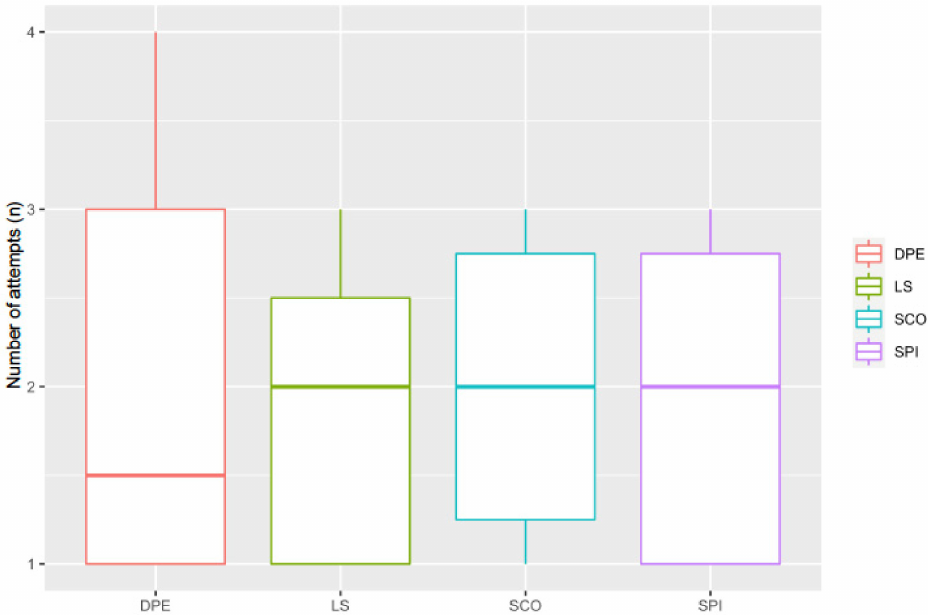
Figure 1. Number of attempts ( n ) required to perform each technique. DPE, dural puncture epidural injection; LS, epidural injection in the lumbosacral space; SCO, epidural injection in the sacrococcygeal space; SPI, injection in the subarachnoid space. No difference was found between the groups.